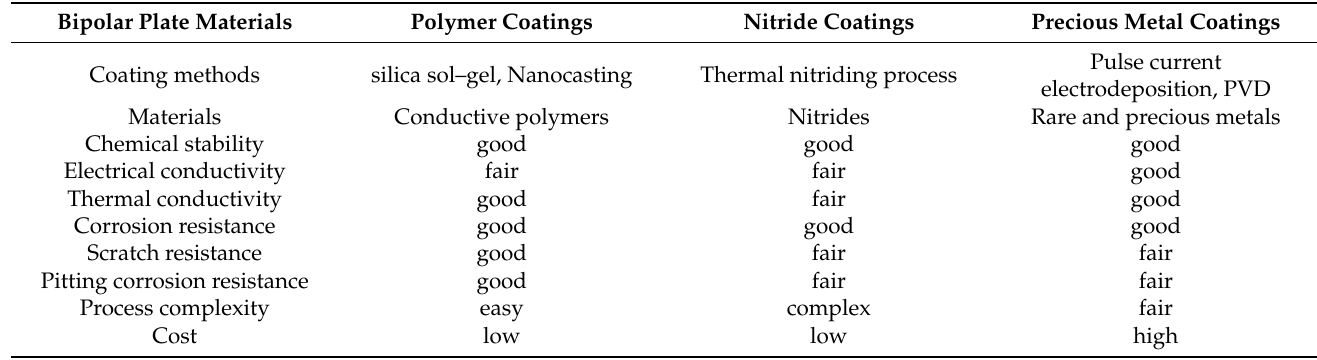
Table 1. Comparison of different